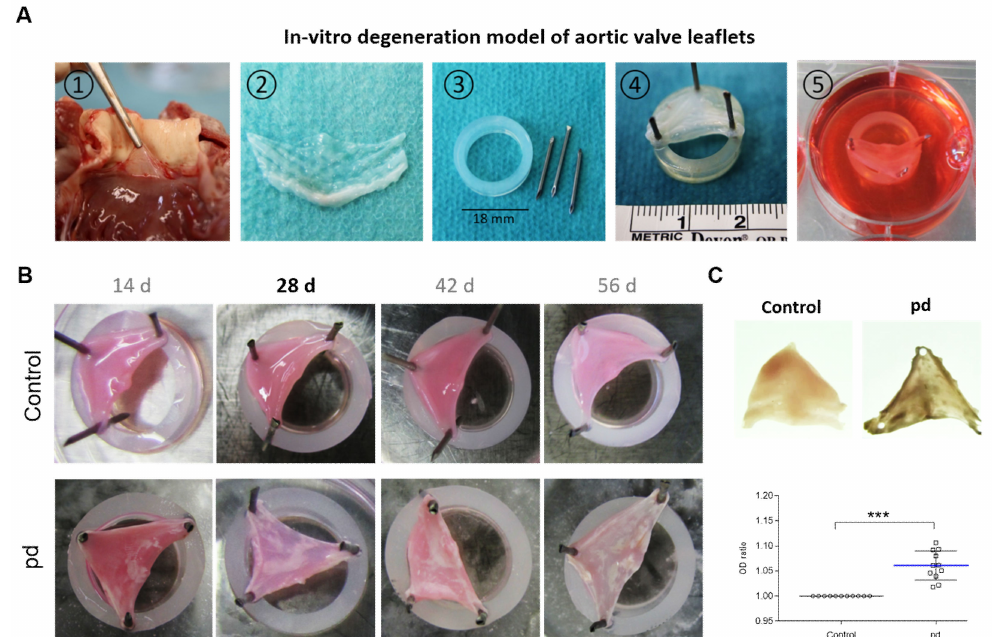
Figure 1. In vitro degeneration model of aortic valve leaflets. ( A ) Application of in vitro CAVD model: (1) Preparation of AV leaflets. (2) Excised AV leaflets after washing in PBS. (3) Required materials (silicon rubber rings and needles). (4) AV leaflet stretched on silicon rubber ring. (5) Cultivation of tensed AV leaflets. ( B ) Images of temporal progression of AV leaflet degeneration. White areas indicate calcified domains. ( C ) Representative transmitted light images of AV leaflets after 28 d cultivation and analysis of optical density (OD). Data ( n = 8) are mean ± SEM. p -values are calculated by using Student’s t-test with Dunn’s multiple comparison post hoc test.; ***: p < 0.001. Pd, (pro-degenerative)